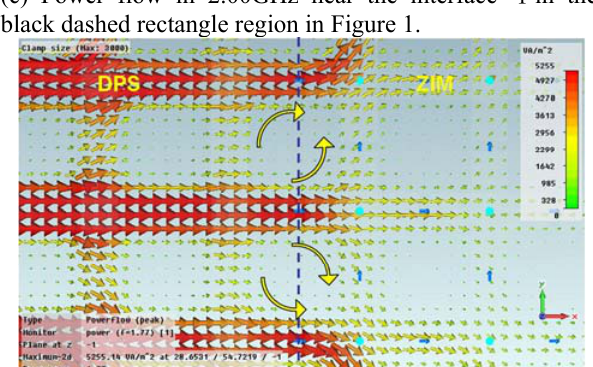
(d) Power flow at the DPS/ZIM interface in 1.77GHz near the interface in the black dashed rectangle region in Ⅰ Figure 1, resulting in little transmission. Figure 3: The power flow at the interfaces of metamaterial with sandwich